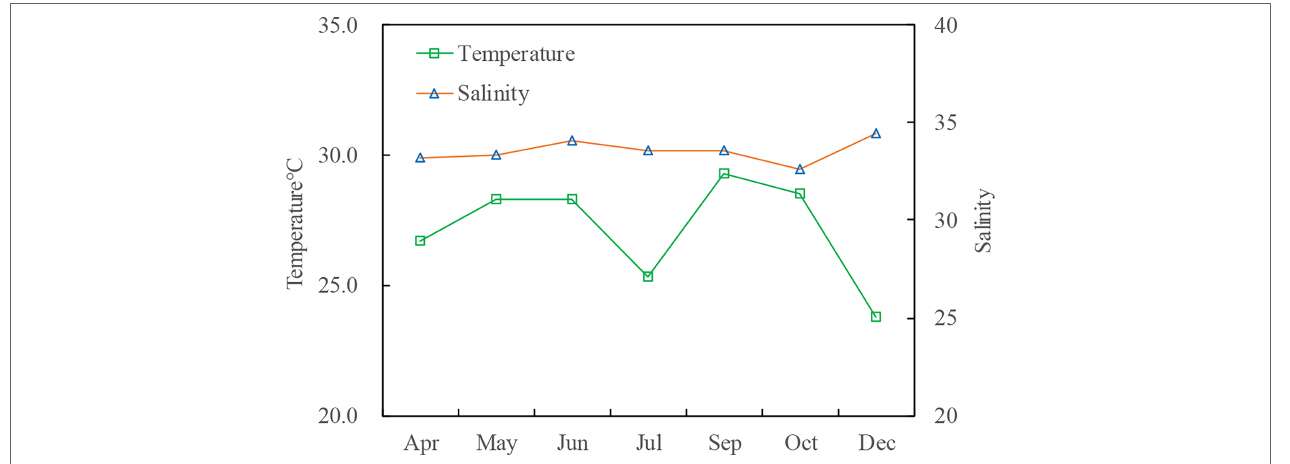
FIGURE 3 | Mean values of the temperature and salinity of the sea ranching area in